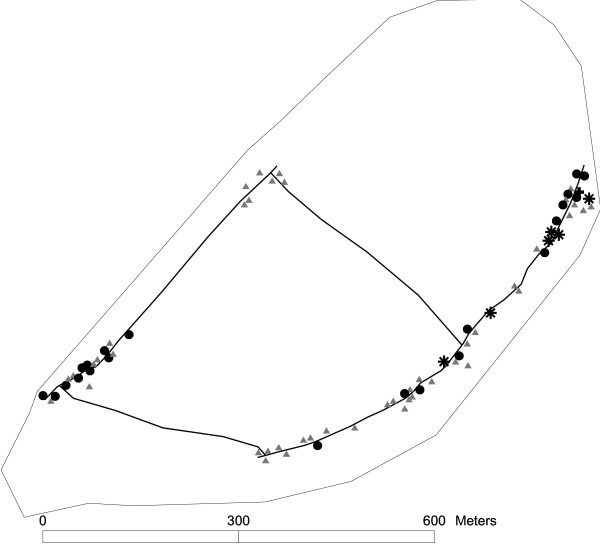
Map of Kembanglemari Island showing the seropositive persons per house.  = 0, ● = 1,  = 2, + = 3 seropositive persons. Not all houses without seropositive persons are shown.